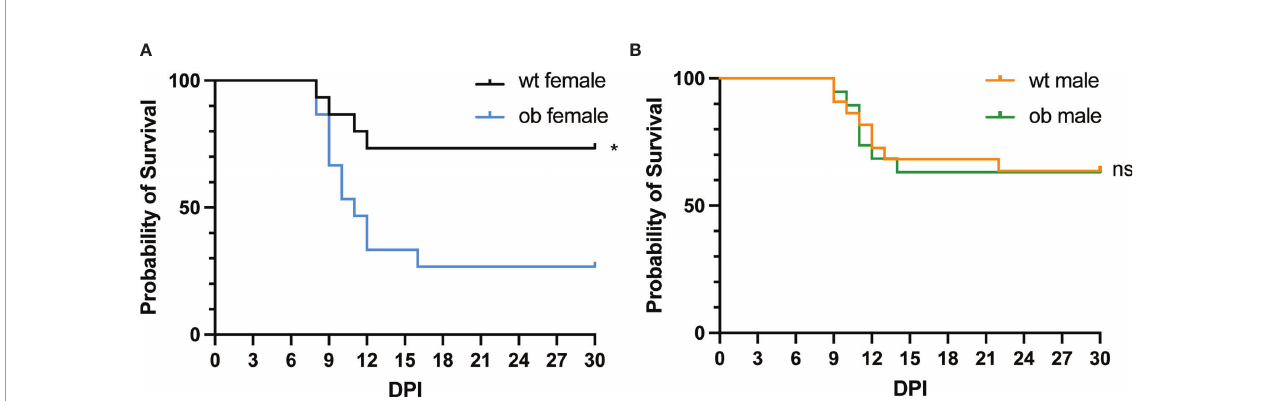
FIGURE 2 | Diet-induced obese mice have enhanced mortality following viral infection. (A, B) Survival of mice following WNV infection. Mice were infected with 100 FFU of WNV via subcutaneous foot pad injection. (A) Wt females (n = 15) displayed a signi fi cantly higher survival rate when compared to ob females (n = 15) (p = 0.0132). (B) No differences were noted in the survival rates between male wt and ob mice (n = 22 and n = 19, respectively) (p = 0.9559). Survival signi fi cance was determined via Mantel-Cox test. *p < 0.05, ns, not signi fi